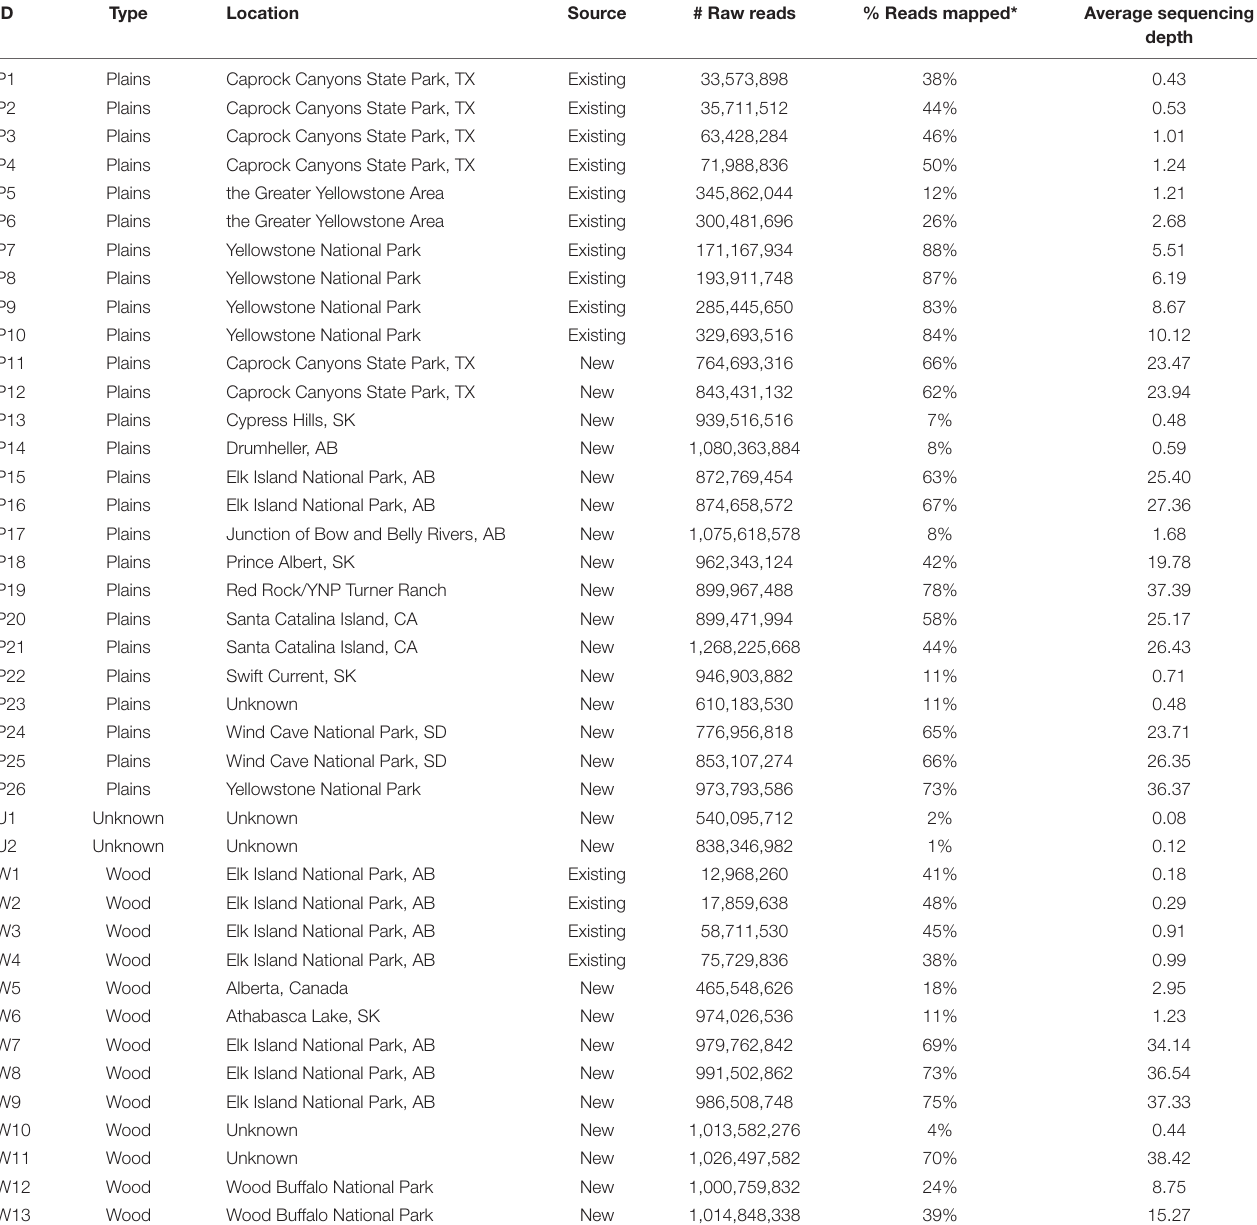
TABLE 1 | List of sequenced